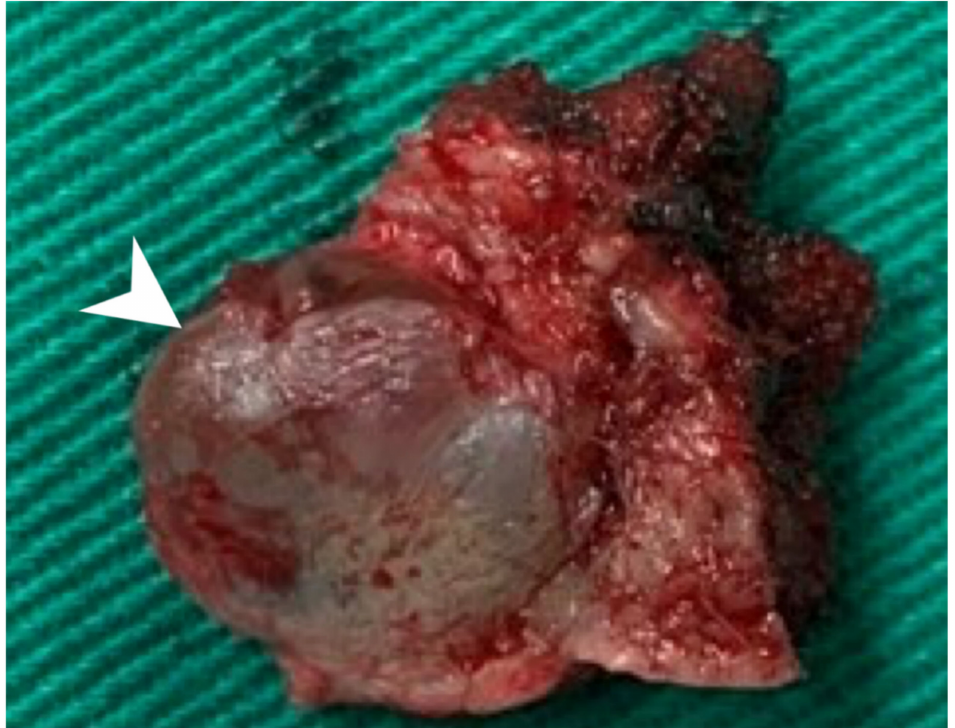
Figure 4. The 1.8 × 1.6 cm mass with safe margins